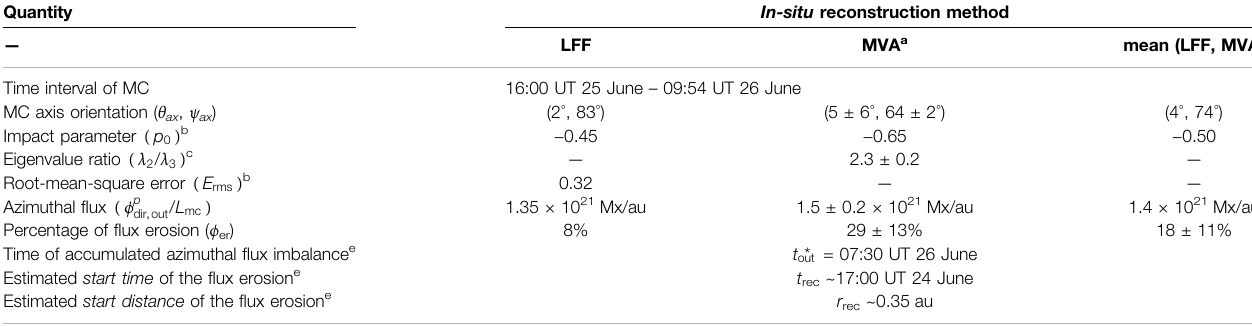
TABLE 2 | Summary of results obtained from the ICME in-situ fl ux analysis at PSP.